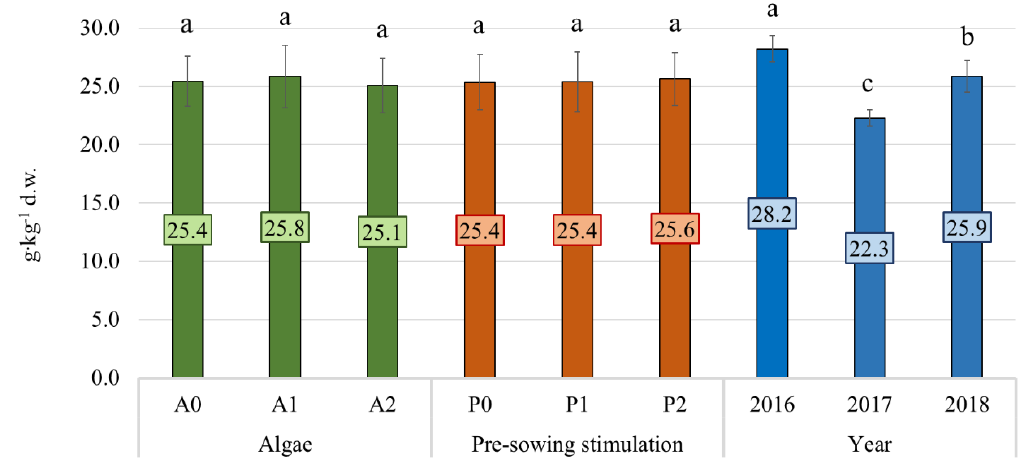
Figure 6. The mean ash content of protein in oat grains in 2016–2018 depending on the experimental factors used. According to Tukey’s HSD test, the means marked with the same letter are not significantly different at α ≤ 0.05.